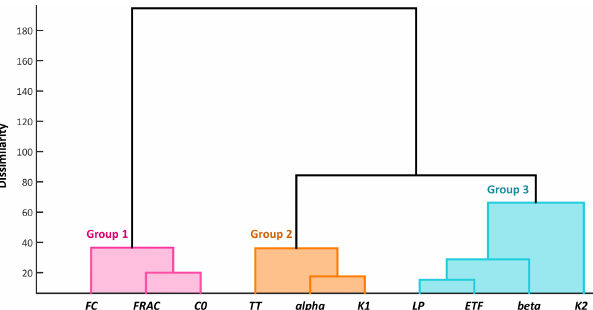
Figure 3. Grouping of the 10 parameters of the HBV-SASK model when applied on the Oldman River basin. The parameters are sorted from the most influential (to the left) to the least influential (to the